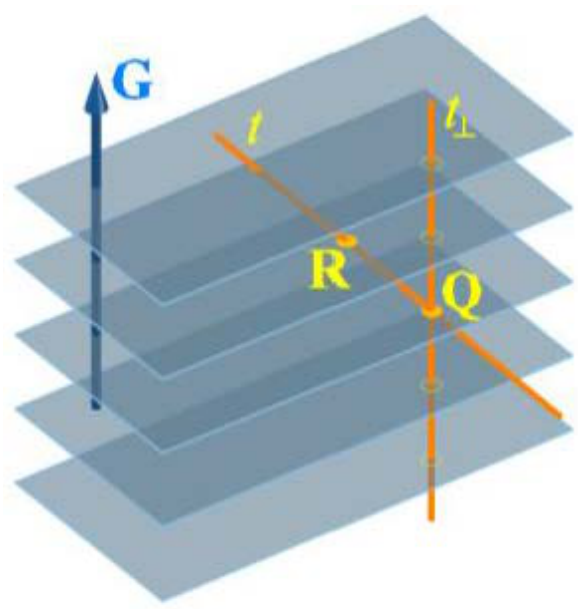
Figure 20: Relation of orthogonality between the gradient of an aflne function and the equipotential planes of the aflne